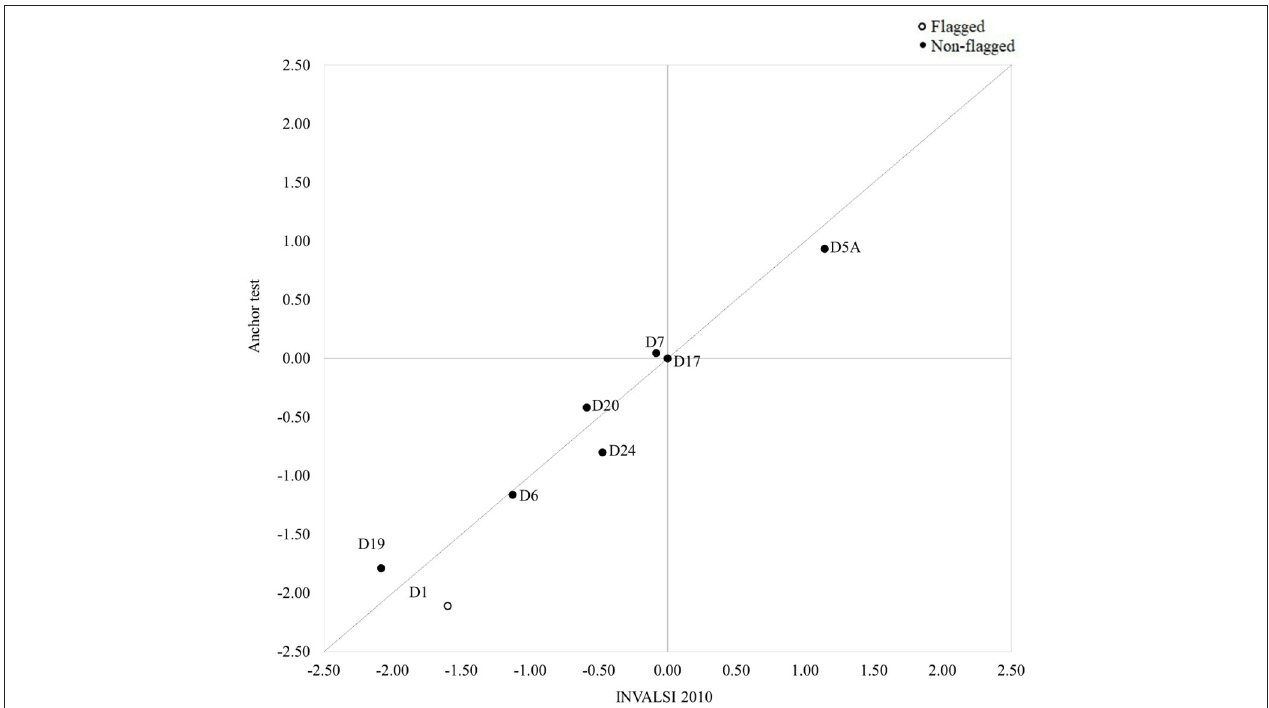
FIGURE 2 | Cross-plot: Difficulty (logit) of common items as estimated in the INVALSI [33] and anchor test forms (full set: r = 0.96; reduced set: r = 0.98).